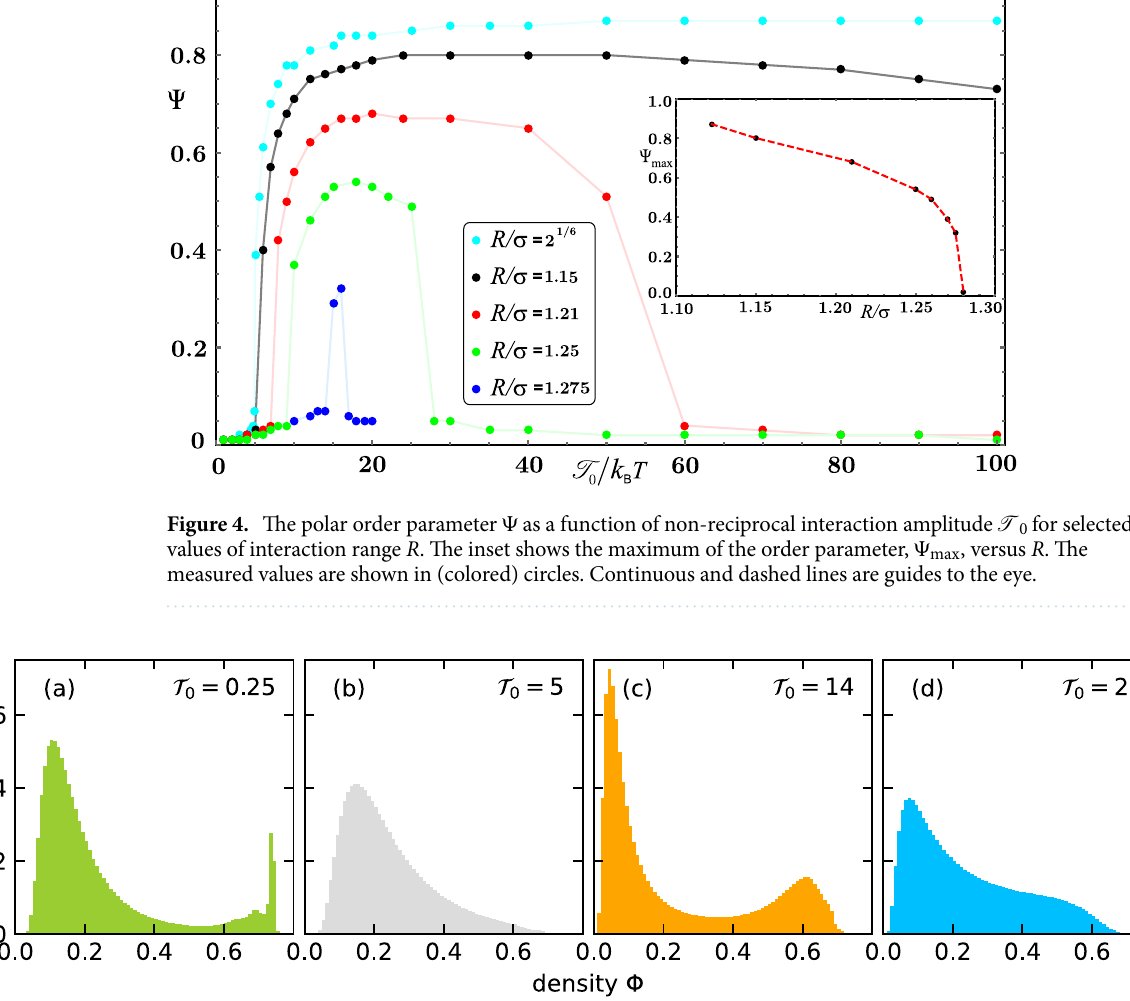
Figure 5. Distribution of the local densities, p (φ) , in the four different states for interaction range R /σ and interaction amplitudes T 0 indicated in each plot. From left to right: MIPS ( a ), dispersed ( b ), flocking (band) ( c ), and flocking (dynamic) ( d ). The colors of the distributions are used in Fig. 6 to indicate the different